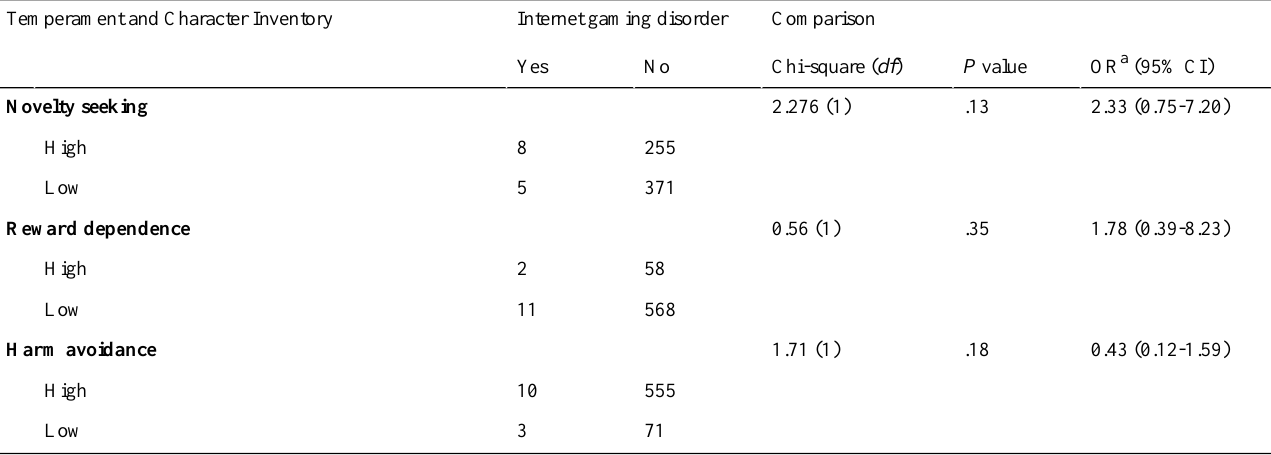
Table 3. Associations between Temperament and Character Inventory and internet gaming disorder.